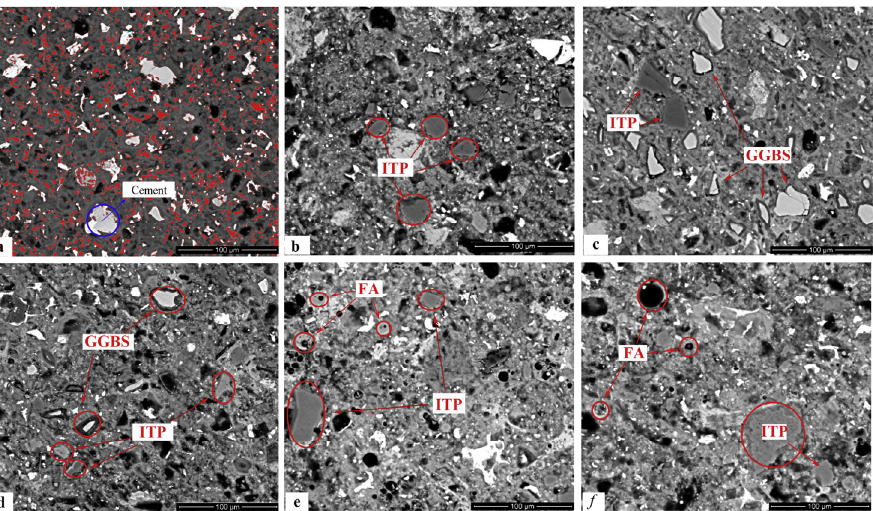
Figure 7. Backscattered secondary electron (BSE) images of steam ‐ cured hardened pastes with iron tailing powder at 90 days: ( a ) 100% cement, ( b ) 50% cement + 50% iron tailing powder, ( c ) 50% ce ‐ ment + 15% iron tailing powder + 35% slag, ( d ) 50% cement + 35% iron tailing powder, ( e ) 50% cement + 15% iron tailing powder + 35% fly ash, and ( f ) 50% cement +35% iron tailing powder + 15% fly ash